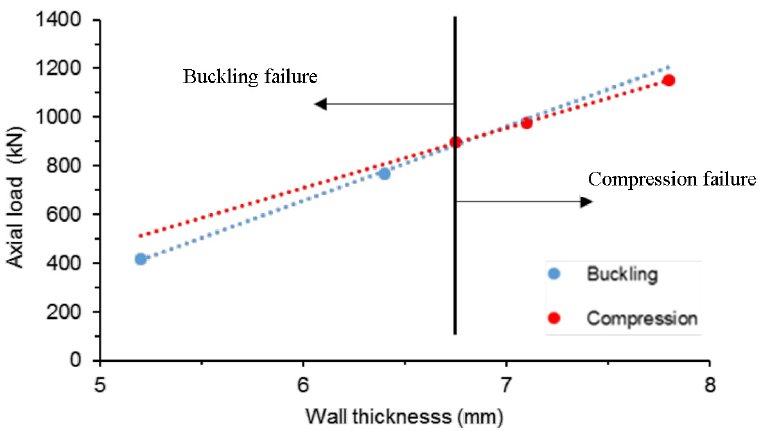
Figure 10. Effect of the wall thickness on the failure mode of pulwound box FRP profile [94].